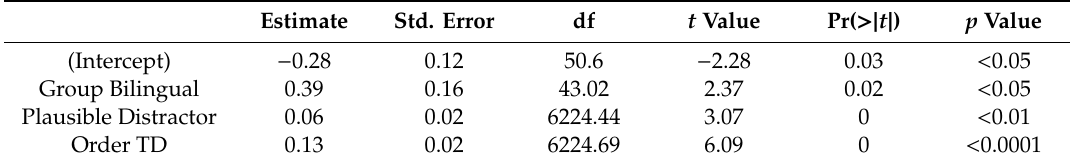
Table A2. Output of mixed-e ff ects regression RT analysis.